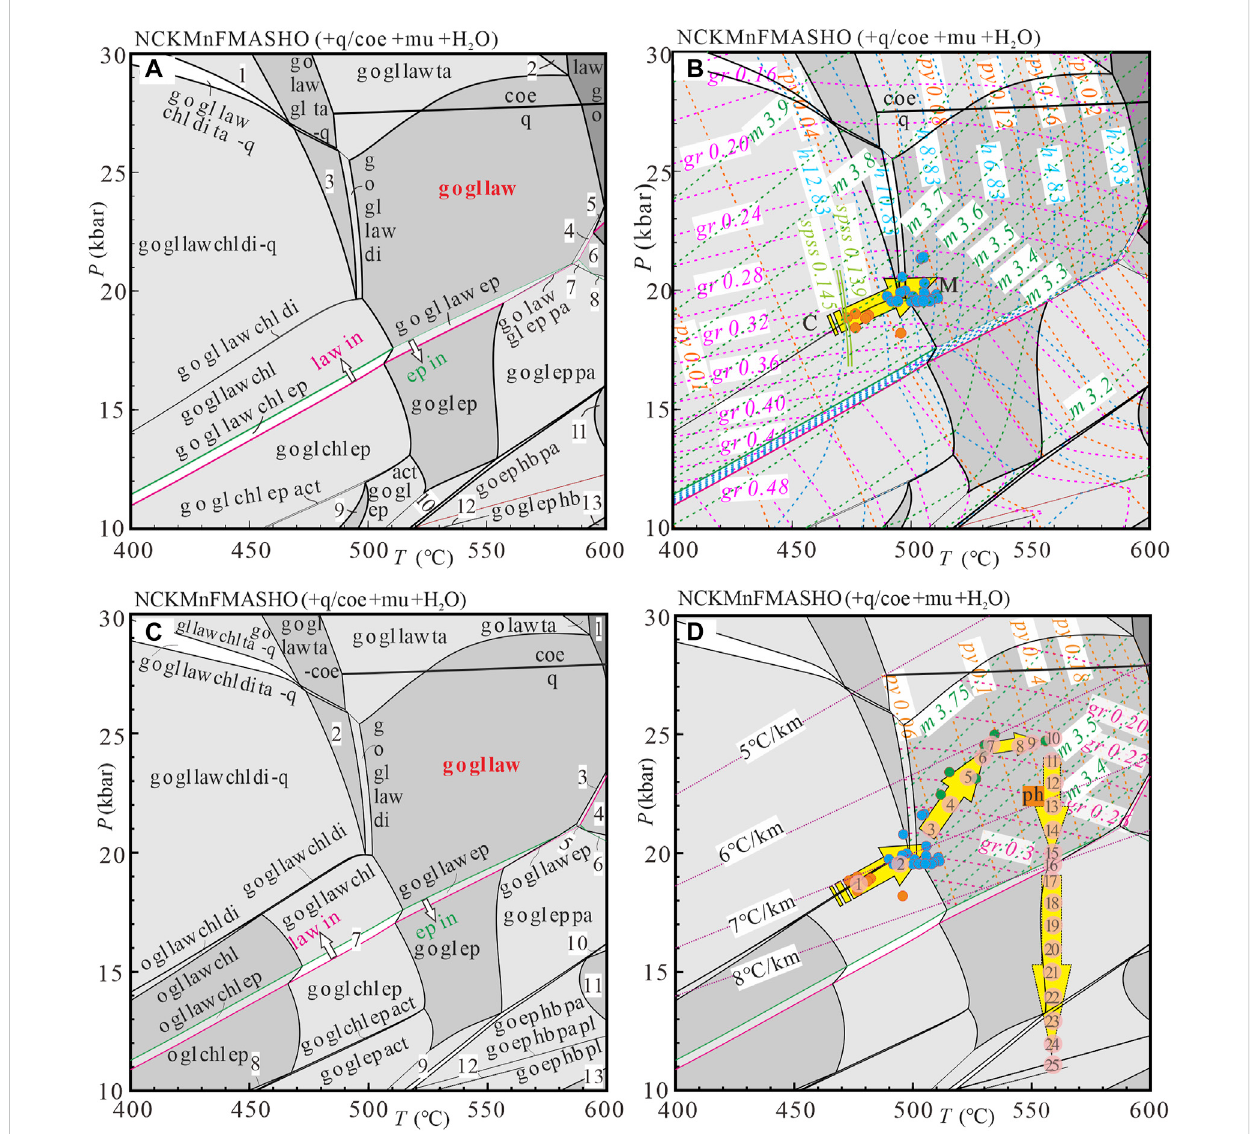
FIGURE 6 P – T pseudosections for the eclogite GQ – 1 using primary bulk rock composition (A,B) and effective bulk rock composition (C,D) in Table 4 gr represents calculated isopleth for grossular in garnet, py represents calculated isopleth for pyrope in garnet, m represents calculated isopleths for Si in phengite and h represents calculated isopleths for H 2 O modal content saturated for relevant phase assemblages. Yellow arrows represent inferred P – T evolution from the prograde to peak, then to retrograde stages. C, M, R1 and R2 represent compositions of garnet core, mantle and rim (inner rim and outer rim), respectively. In fi gure (D) , the calculated geothermal gradient during the prograde process is 6 ° C – 7 ° C/km (assuming 2.8 km/1 kbar, after Weietal.,2010).In (A)